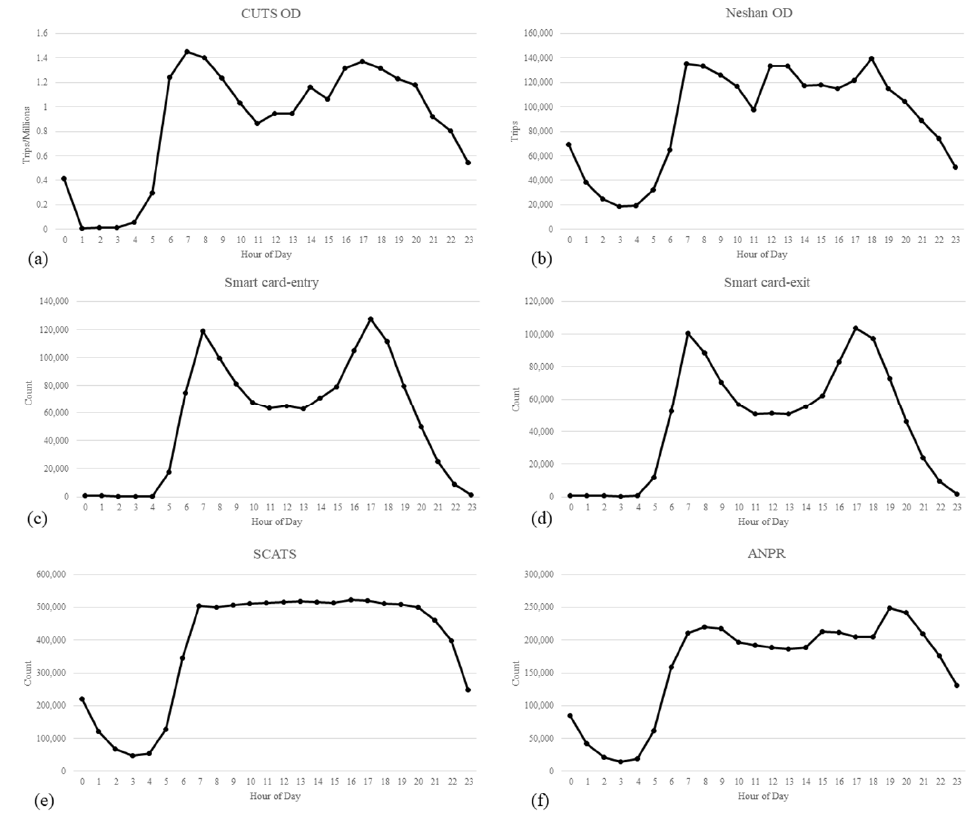
Figure 5. Temporal distribution of averaged data for weekdays. ( a ) temporal distribution of trips in OD matrix of CUTS, ( b ) temporal distribution of trips in OD matrix of Neshan, ( c ) temporal distribution of passengers entering to subway stations, ( d ) temporal distribution of passengers exit from subway stations, ( e ) temporal distribution of loop counts in intersections, ( f ) temporal distribution of ANPR camera count .